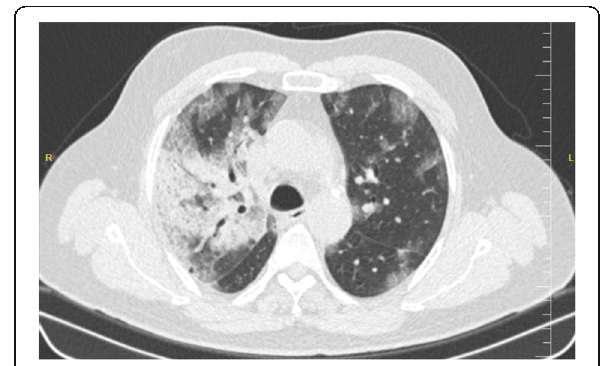
Fig. 3 An axial chest CT from a 60-year-old man with COV İ D-19 pneumonia. Non-contrast-enhanced chest CT image showed multiple peripheral ground-glass opacities distributed in the bilateral lung fields, combined with consolidation